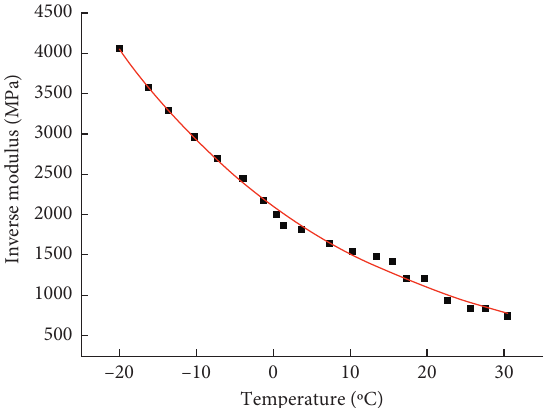
Figure 7: Correlation between inversion modulus of asphalt surface course and Table 6: Correlating data of pavement temperature and inversion modulus of surface course.